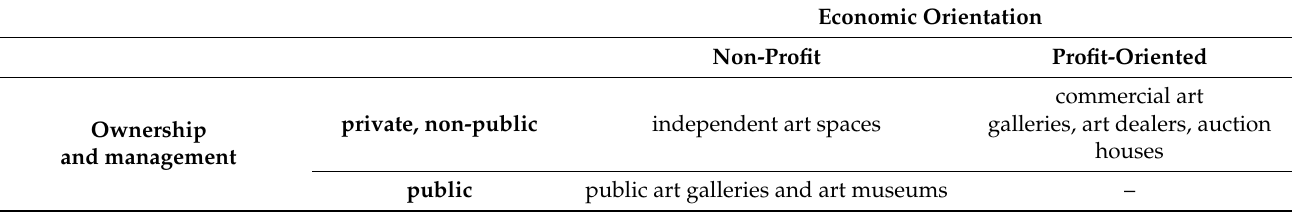
Table 1. Independent art spaces within the contemporary art